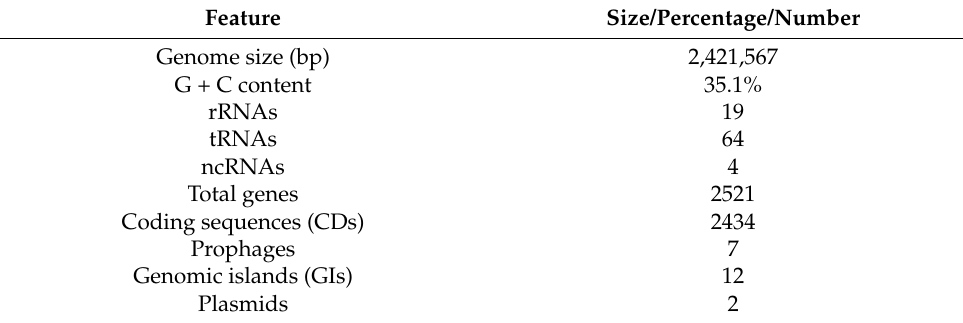
Figure 1. Circular genome plot of L. lactis N8. From outer to inner circle: gene function annotation results, genome GC content, genome GC skew. Table 2. Basic genomic characteristics of L. lactis